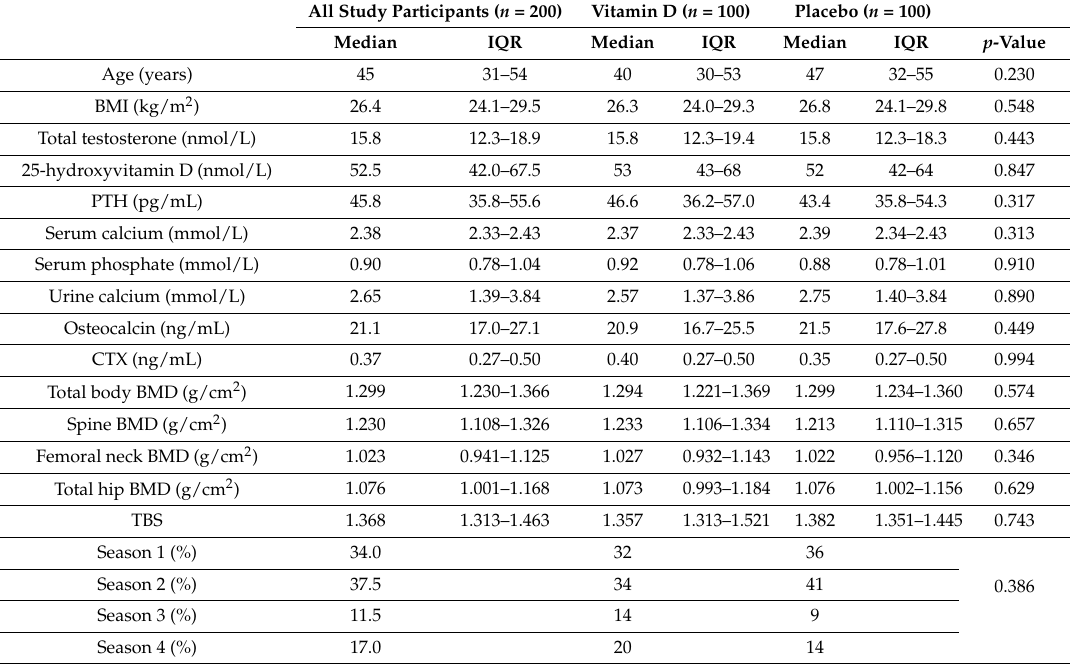
Table 1. Baseline characteristics of study